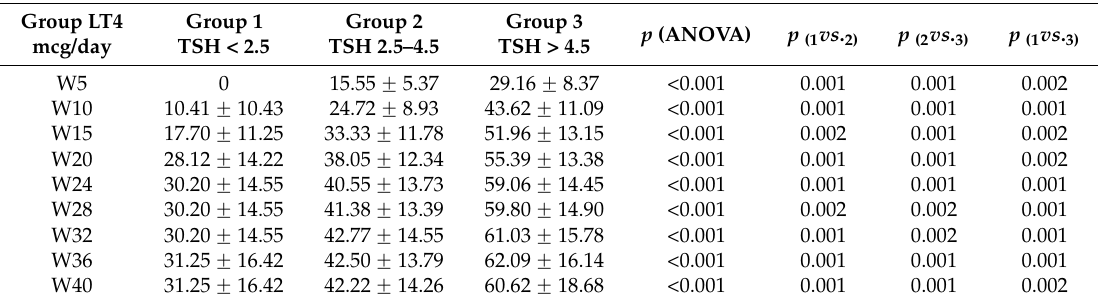
Figure 3. Linear regression of the final LT4 dose dependent on the initial TSH value, in cases with asymptomatic autoimmune thyroid disease. Table 3. Mean LT4 supplemental doses in all the three study subgroups, in all evaluation along the pregnancy.